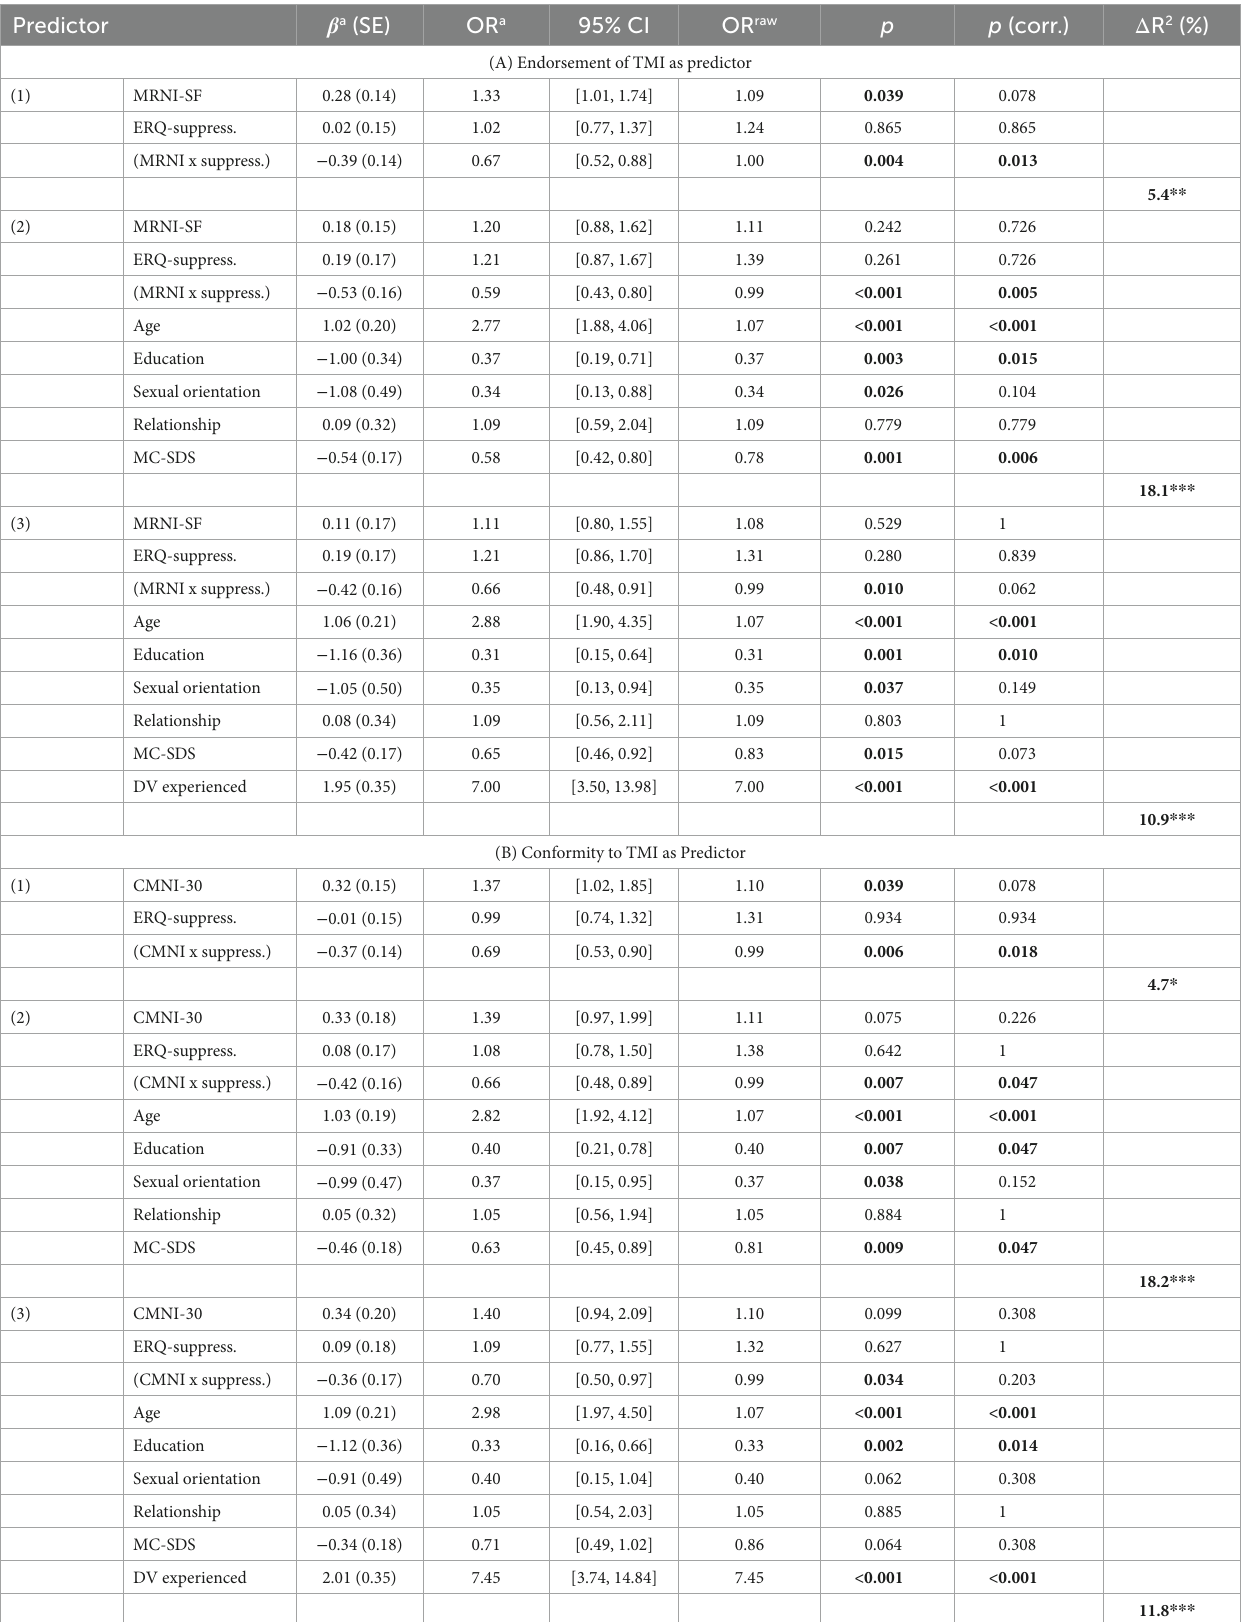
TABLE 5 Moderation models with DV perpetration as outcome and expressive suppression as moderator. Predictor β a (SE) OR a 95% CI OR raw p p (corr.) Δ R 2 (%)